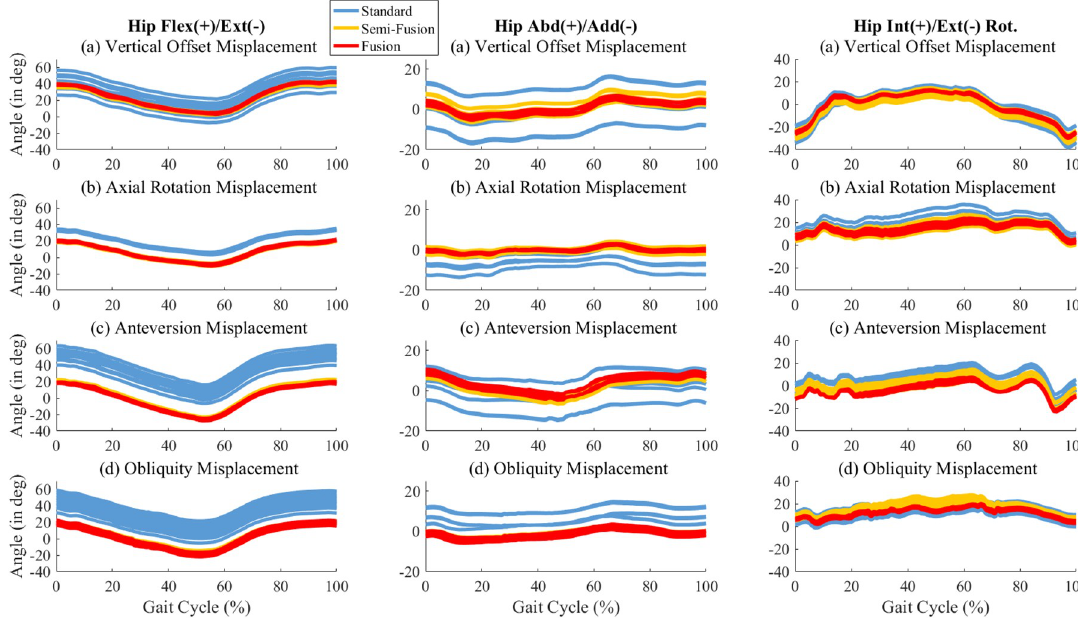
Fig 6. Right hip kinematics with the standard method, semi-fusion method and fusion method. The marker misplacements is as follow: (a) Vertical Offset, (b) Axial Rotation, (c) Anterversion, (d)